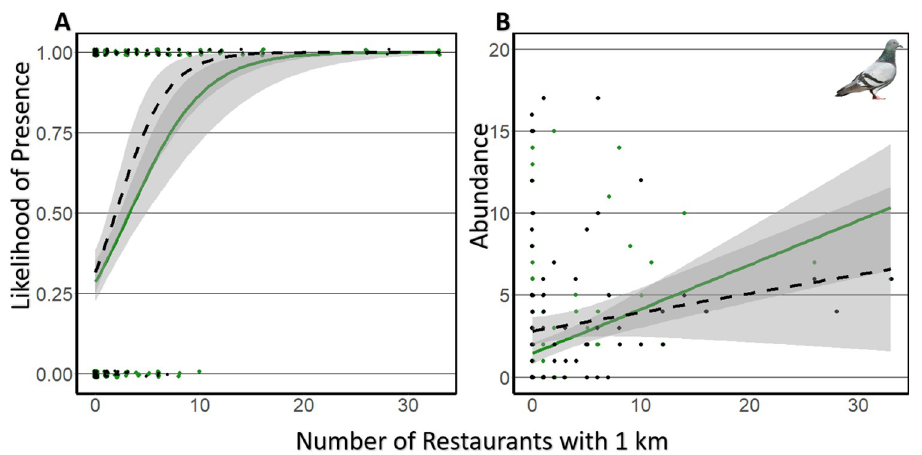
Fig 2. Significant correlations between restaurant abundance and rock pigeon, the most common species associated with restaurants. Each point represents the species presence (A) or abundance (B) for spring (green) or winter (black). Trendlines for spring (green) and winter (black dashed) are shown as well as their associated 95% confidence intervals in gray. Note that points for presence (A) are jittered to better display the information. A total of 128 site and year combinations are included for the spring and 161 site and year combinations are included for the winter. For the spring, 29% of all sites are occupied representing a total abundance of 304 individuals. For the winter, 51% of all sites are occupied accounting for 479 individuals.